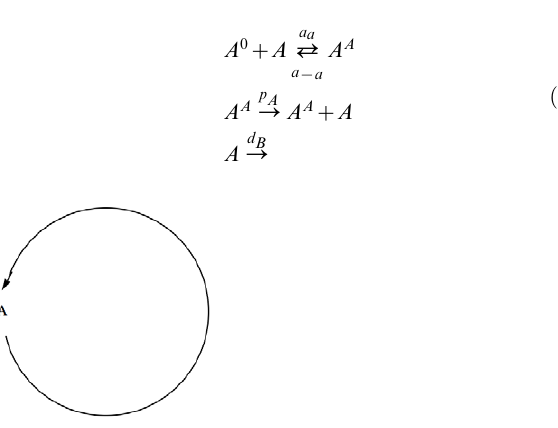
Figure 4. Regulation graph describing a self-activating protein.